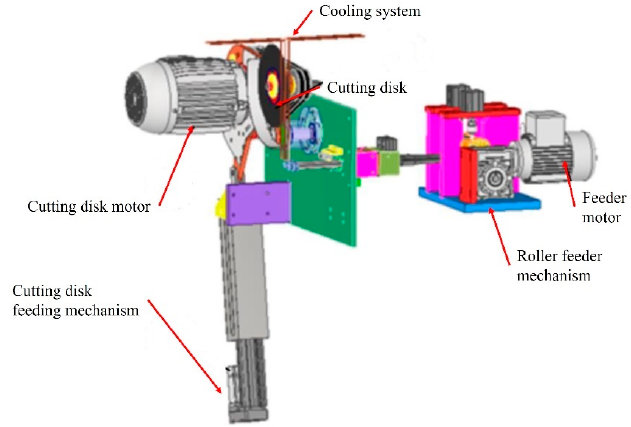
Figure 4. Scheme of the current cutting system.